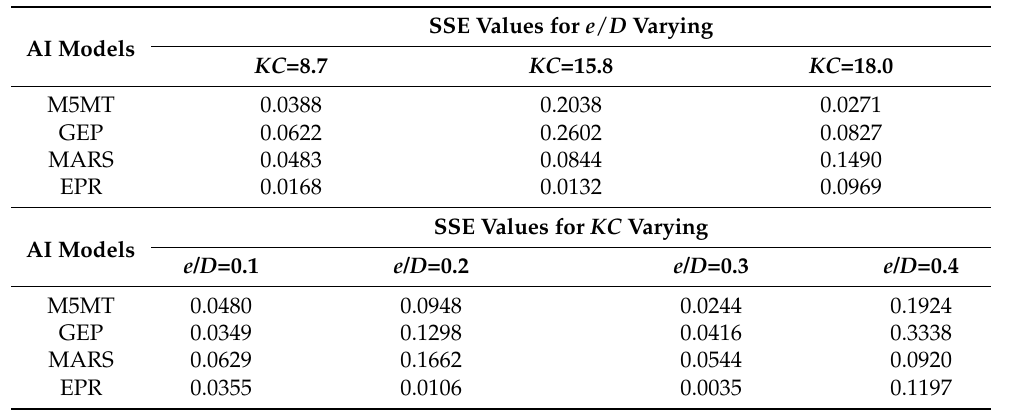
Table 6. SSE values for the considered AI models when predicting V ∗ KC values.